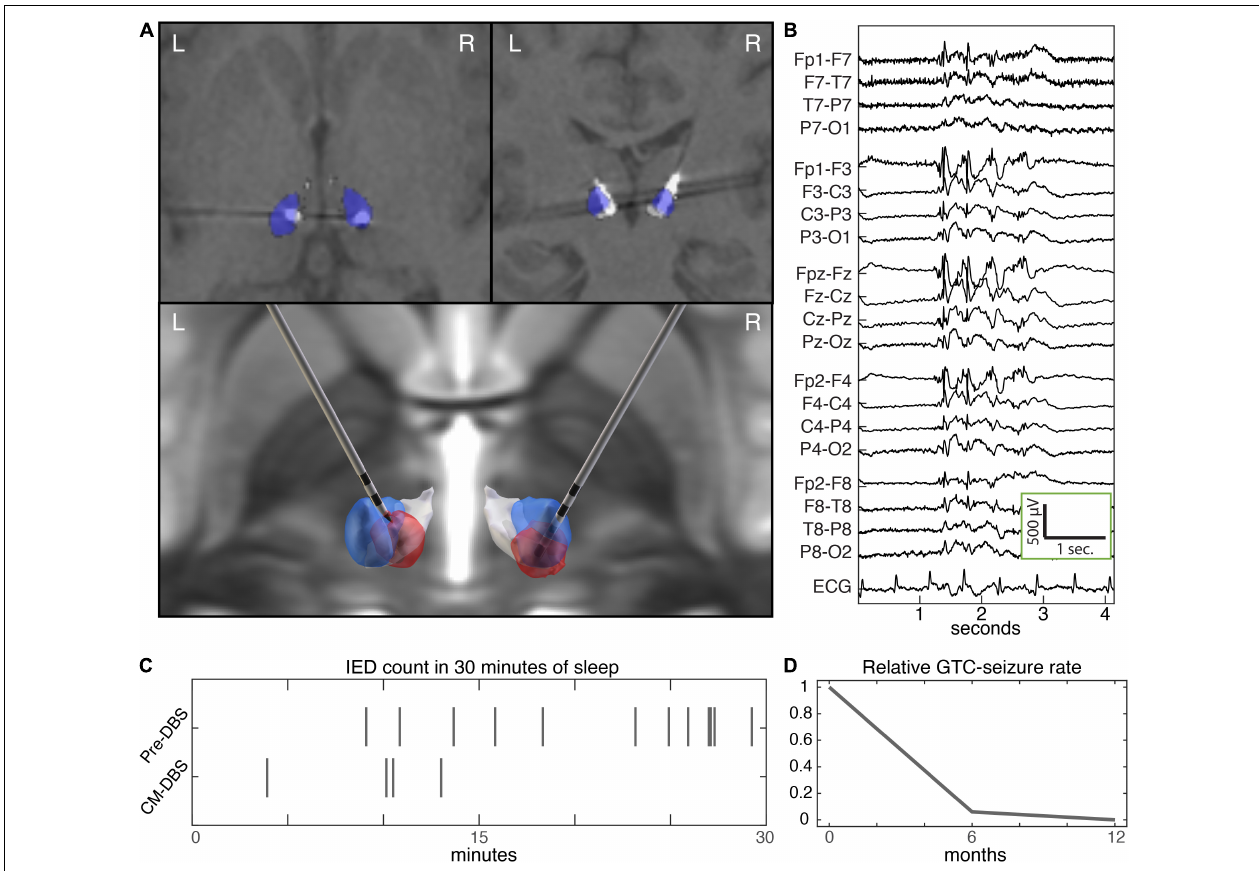
FIGURE 2 | Centromedian DBS and epilepsy biomarkers. (A) Axial (top left) and coronal (top right) sections of post-operative CT coregistered to pre-operative T1 MP-RAGE MRI, and rendered implantation (bottom). The CM and Pf nuclei are colored blue and white, respectively. Neurological orientation (left hemisphere is left). The estimated VTA (red) based on stimulation parameters at last follow-up (VTA modeling with Lead-DBS SimBio/FieldTrip) (Horn and Kühn, 2015). (B) Interictal generalized spike and wave discharges. (C) Raster plot of epileptiform discharges during initial 30 min of stage N2 sleep at baseline and with CM DBS. (D) Seizure rate at baseline over the 6-months preceding DBS, and during 1 year of follow up with CM DBS. CM, centromedian; DBS, deep brain stimulation; MP-RAGE, magnetization-prepared rapid gradient echo; Pf, parafascicular; VTA, volume of tissue